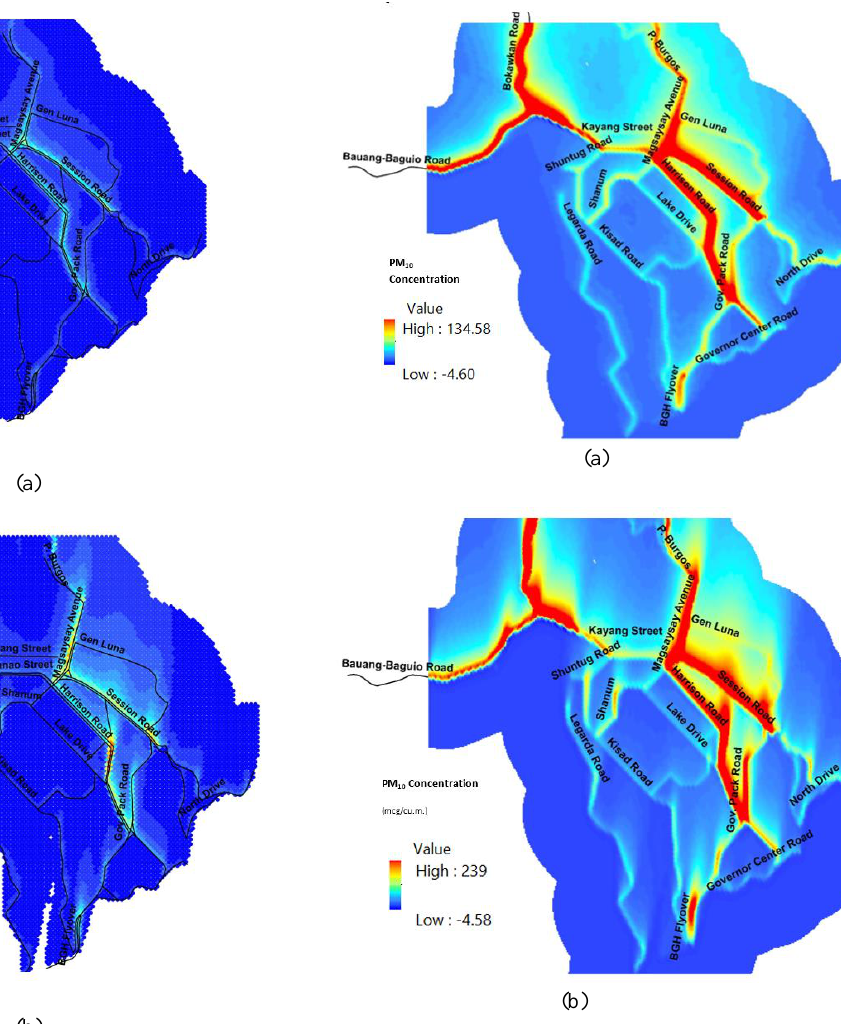
Figure 7. Geostatistical modeling results for (a) daytime hour 6AM-7AM and (b) nighttime hour